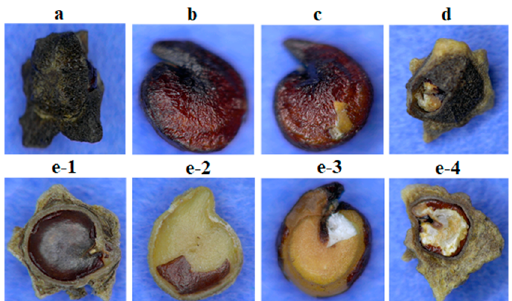
Figure 1. Five damage classes ( a – e ) of sugar beet seeds: ( a ). Partially broken pericarp and/or outer testa (class 1), ( b ). Completely broken pericarp and outer testa (class 2), ( c ). Fractured pericarp and outer testa, partially crushed inner testa with sound embryo (class 3), ( d ). partially broken pericarp and/or outer testa, damaged inner testa with intact embryo (class 4), ( e1–4 ). Different types of severe damages to the embryo or seeds without any embryo like the pericarp or outer testa (class 5).